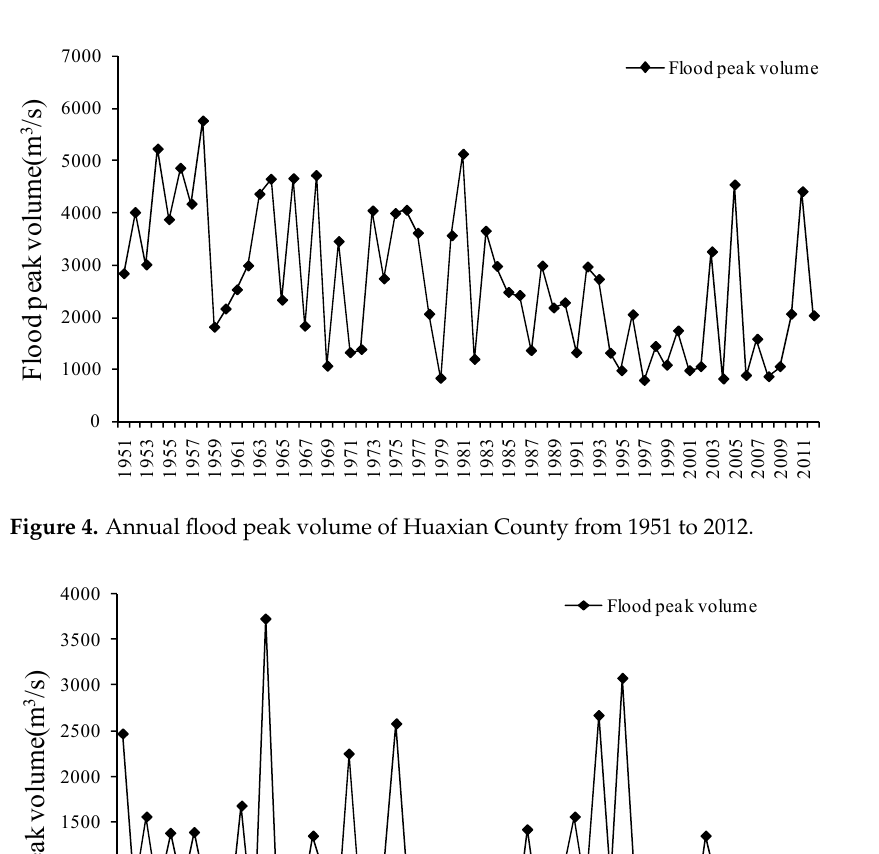
Table 2. Selected copulas for multi-reservoir joint flood risk distribution with minimum AIC and BIC.